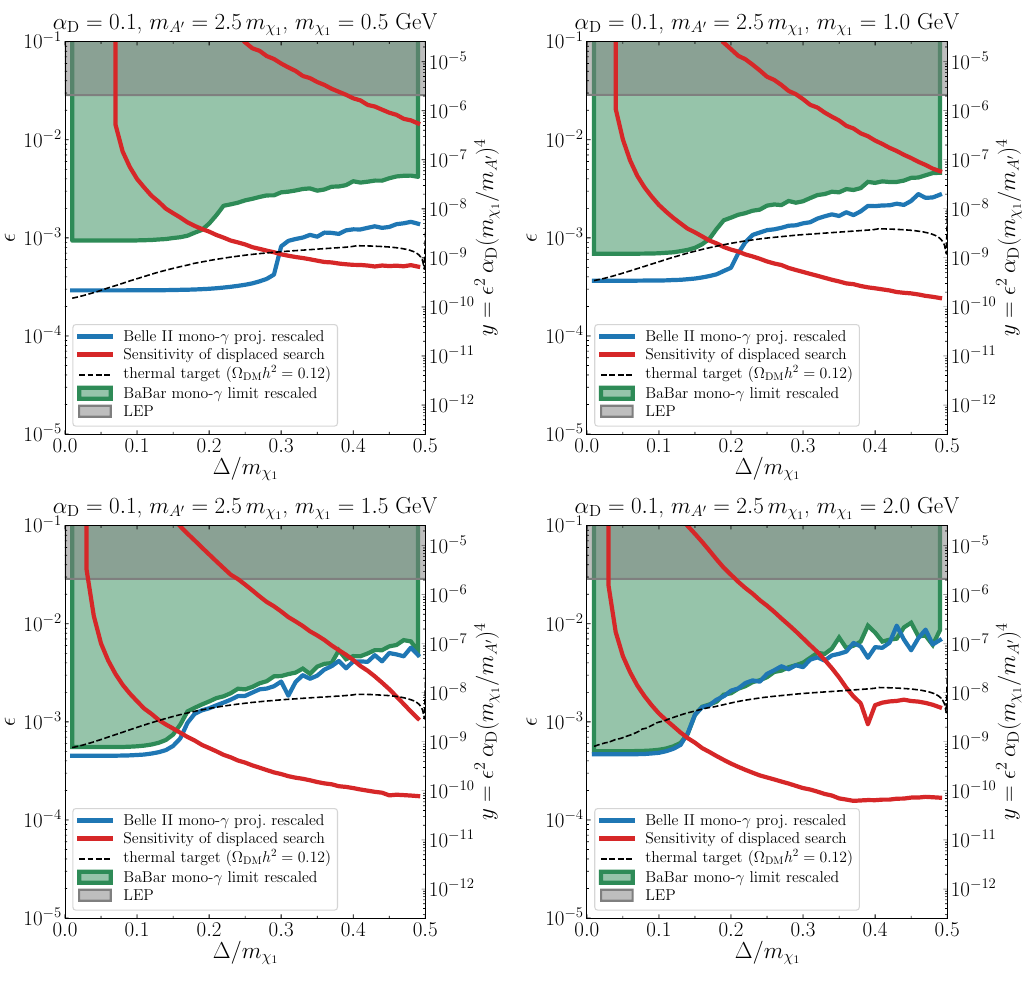
Figure 9 . Sensitivity of Belle II to the parameter space of inelastic DM as a function of (cid:1) for an integrated luminosity of 20 fb (cid:0) 1 for m A